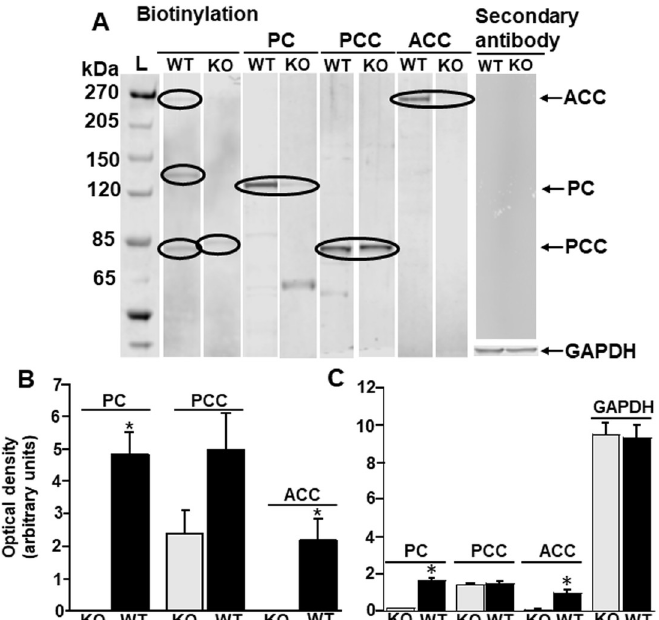
Fig 7. Expression of apo-carboxylases and holo-carboxylases in tissue from HLCS knockout (KO) and wild-type (WT) embryos. (A) Steptavidin blots (“biotinylation”) and immunoblots of carboxylases in HLCS KO and WT embryos. The lanes to the far right depict transblots probed with secondary antibody only (top) and anti-GAPDH (bottom). (B) Densitometry analysis of holocarboxylases probed with streptavidin. (C) Densitometry analysis of carboxylase expression probed with anti-PC, anti-PCC and anti-ACC. Note that the antibodies detect both biotinylated and non-biotinylated carboxylases. Data were presented as mean ± SD ( � P < 0.05 vs control, n = 3). KO, HLCS knockout; WT, HLCS